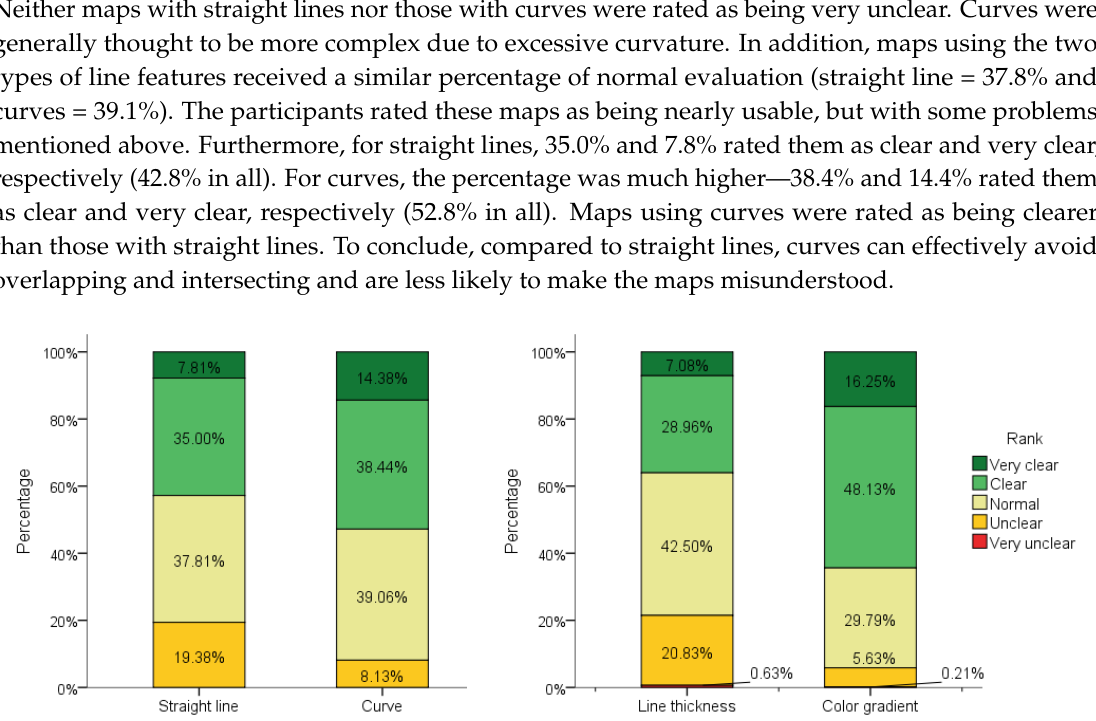
Figure 4. Statistics for the two different representations of the flow volume and Mann-Whitney U test results (** p < 0.01 and NS = not significant). ( a ) Accuracy; ( b ) finish time; ( c ) fixation count; ( d )